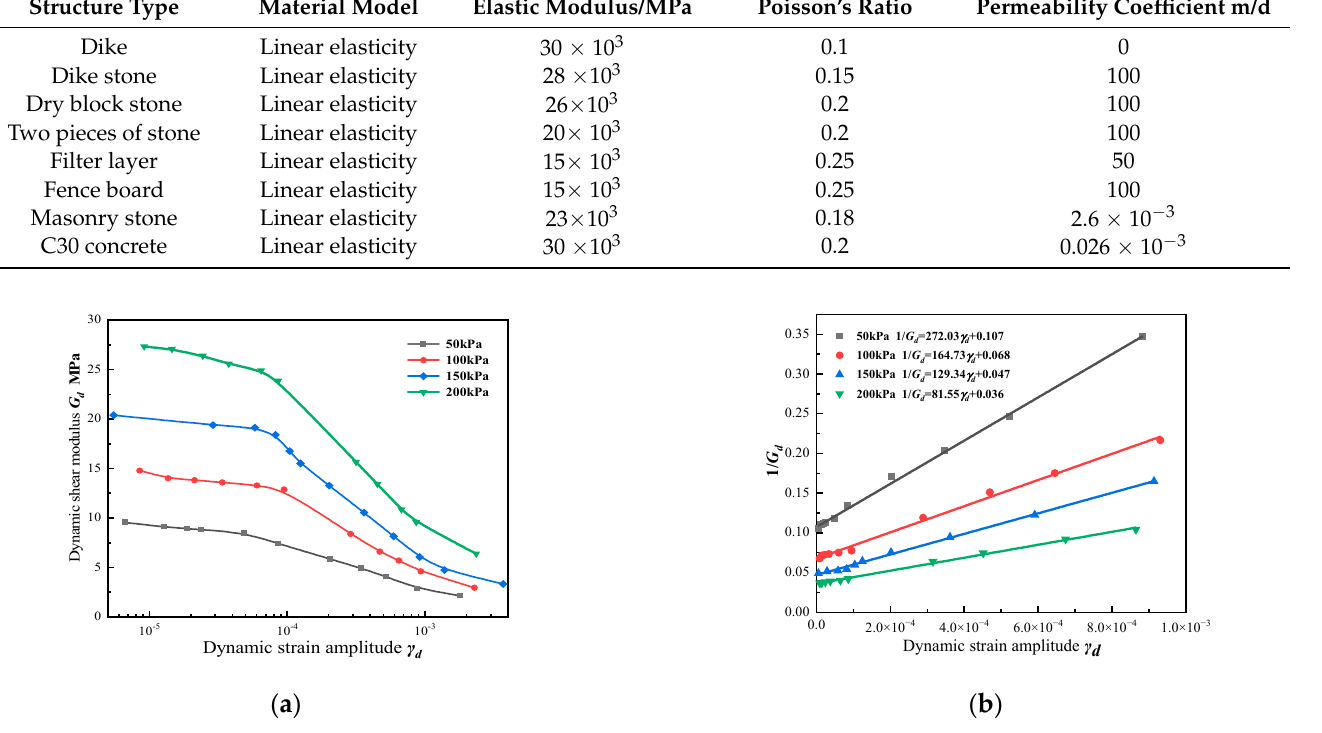
Figure 3. (a) Dynamic shear modulus–dynamic strain amplitude relationship curve under different confining pressure, (b) Reciprocal of dynamic shear modulus–dynamic strain amplitude relationship curve under different confining pressure.